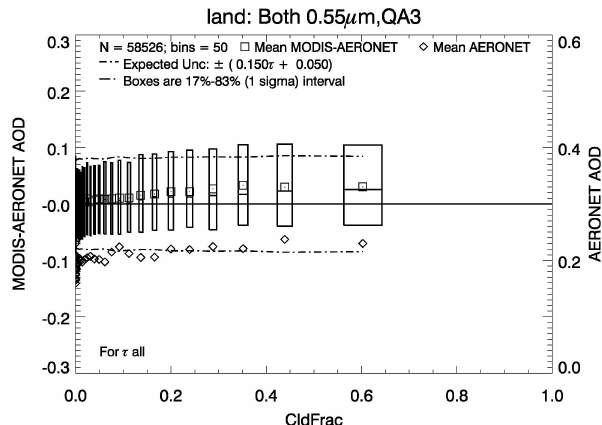
Fig. 8. Differences between MODIS and AERONET-reported AOD at 0.55µm (MODIS-AERONET) vs. MODIS-retrieved cloud frac- tion, for QAC=3. Explanation of symbols is same as for Fig.